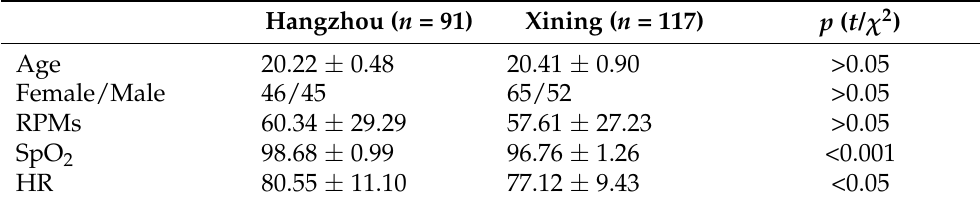
Table 1. Demographic and physiological